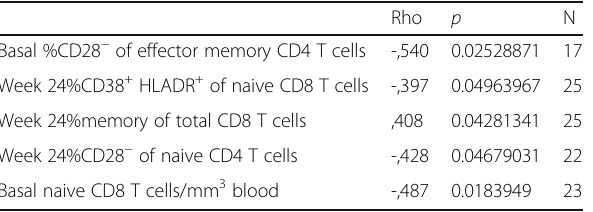
Table 2 Phenotypes of CD4 and CD8 T cells significantly correlating with week 24 CD4/CD8 ratio. Only basal and week 24 values were analyzed. Rho values correspond to univariate Spearman correlation. N, sample size, according to availability